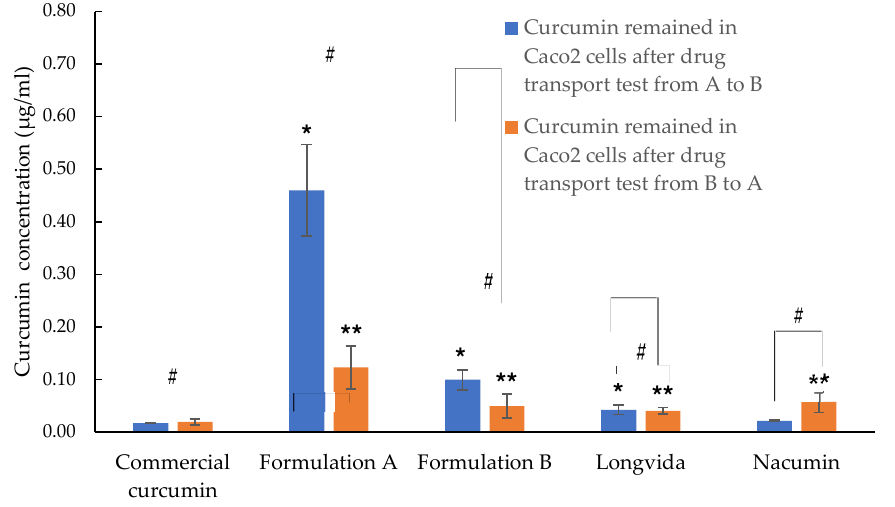
Figure 16. Curcumin accumulation in the Caco-2 cell after the drug transport experiment from the A to B and B to A directions ( n = 9, mean ± SD). * Denotes the statistically significant difference in curcumin cellular accumulation between a formulation sample and commercial curcumin from A to B. ** denotes the statistically significant difference in curcumin cellular accumulation between a formulation sample and commercial curcumin, from B to A. Note: # denotes a statistically significant difference between the curcumin cellular accumulation of a test sample from A to B and B to A ( p ≤ 0.05).